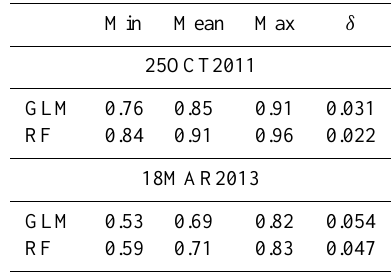
Table 5. AUC values achieved by the GLM and RF models for both study cases. Summary statistics are computed considering the 100 runs performed ( δ stands for standard